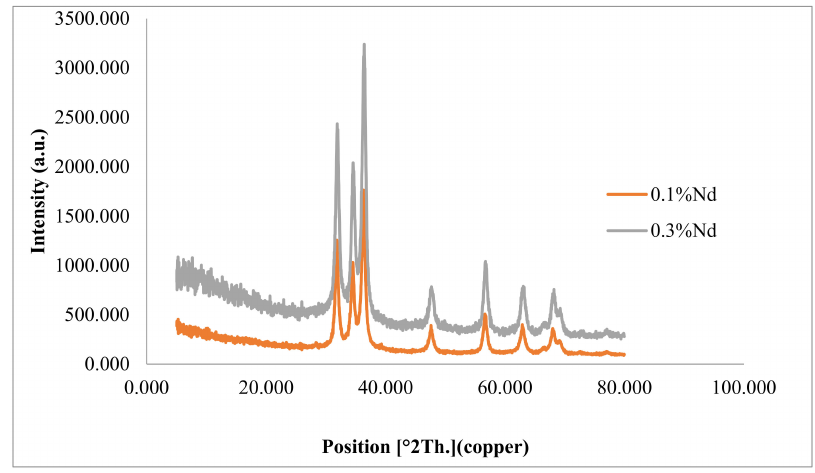
Figure 3. XRD patterns of ZnO doped with different values of neodymium nitrate. Bandgap value was obtained with a Perkin-Elmer lambda 25 UV-Vis spectrophotome- ter device (Figure 4a) and the Tauc plot method. Equation (7) was also used: